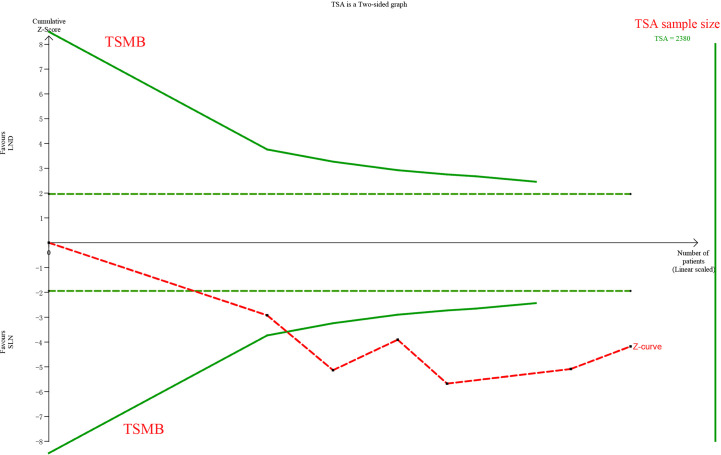
TSA of pelvic lymph nodes, α = 0.05, β = 0.8, relative risk reduction = −73.8%, incidence in control group = 16.4%, two-sided test.